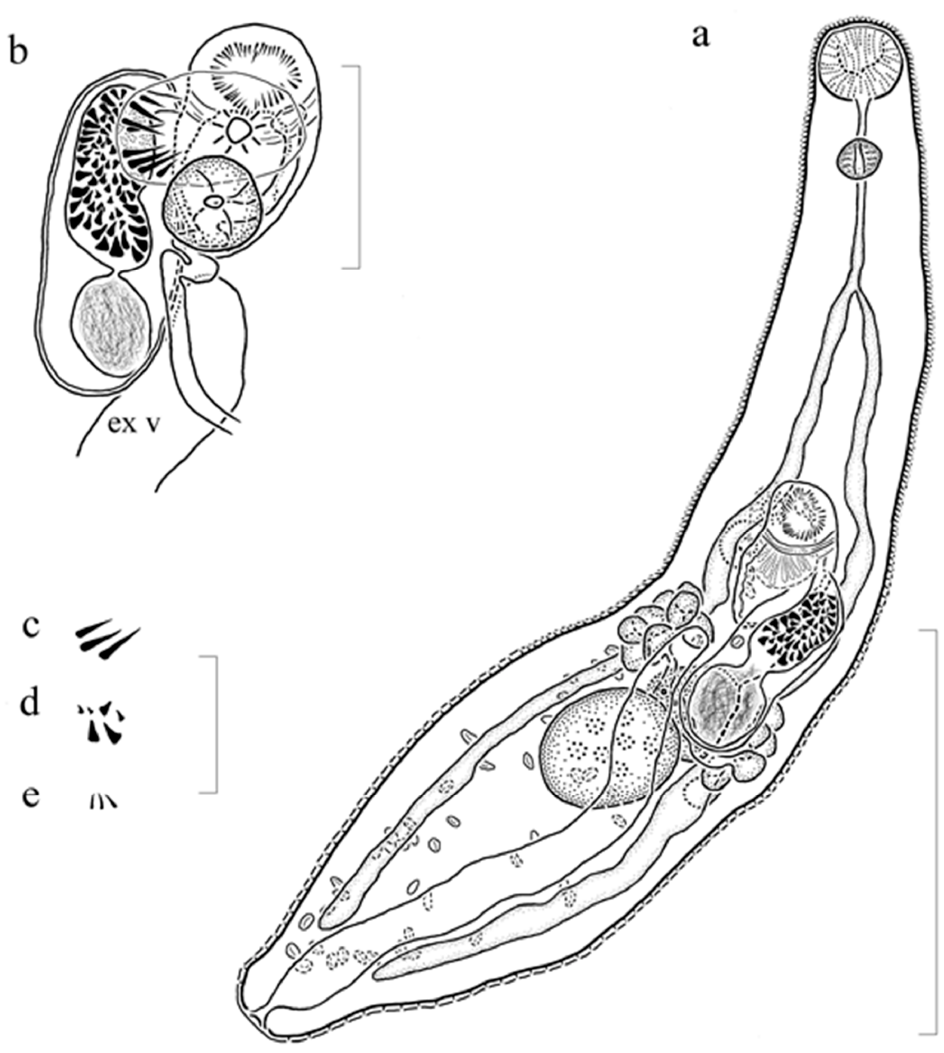
Figure 2. Genolopa vesca n. sp. from Haemulon sciurus . ( a ) Dorsal view, holotype, scale bar 400 µm; ( b ) ventral view, terminal genitalia and anterior extent of the excretory vesicle (ex v), note anterior portion of the terminal organ is a cross sectional view, scale bar 100 µm; ( c ) genital atrium spines, scale bar 50 µm; ( d ) cirrus spines, note the different sized spines, scale bar 50 µm; ( e ) anterior terminal organ spines, scale bar 50 µm.